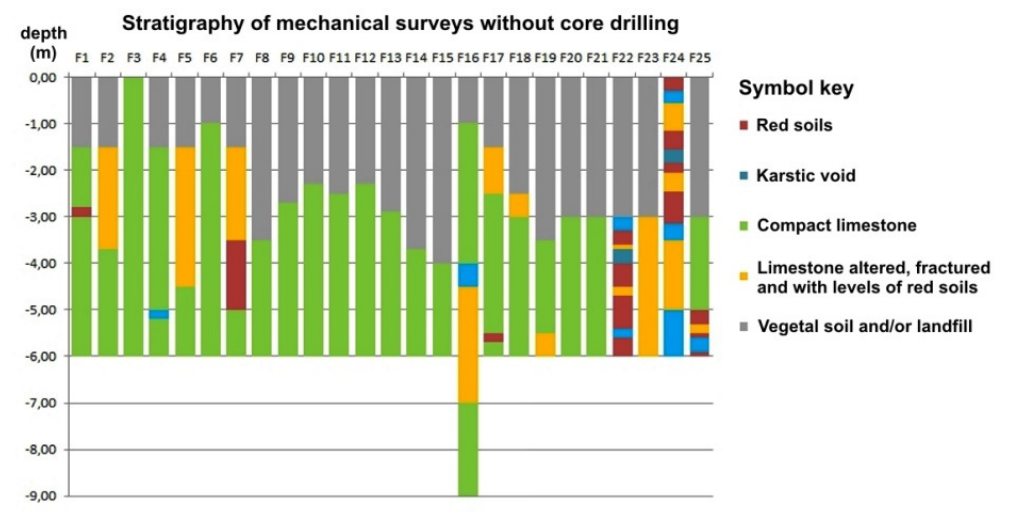
Figure 5: Stratigraphy obtained from the core destruction borings.